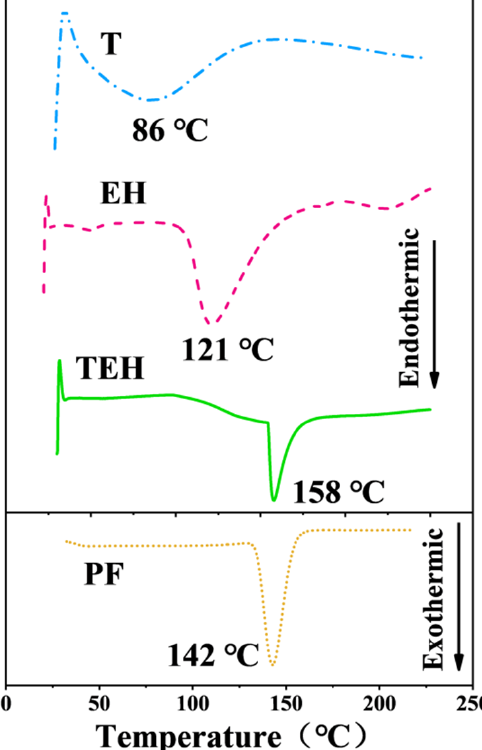
Figure 3. DSC thermograms of the tannin (T), epoxy soybean oil-hexanediamine (EH) and tannin-epoxidized soybean oil-hexanediamine (TEH).